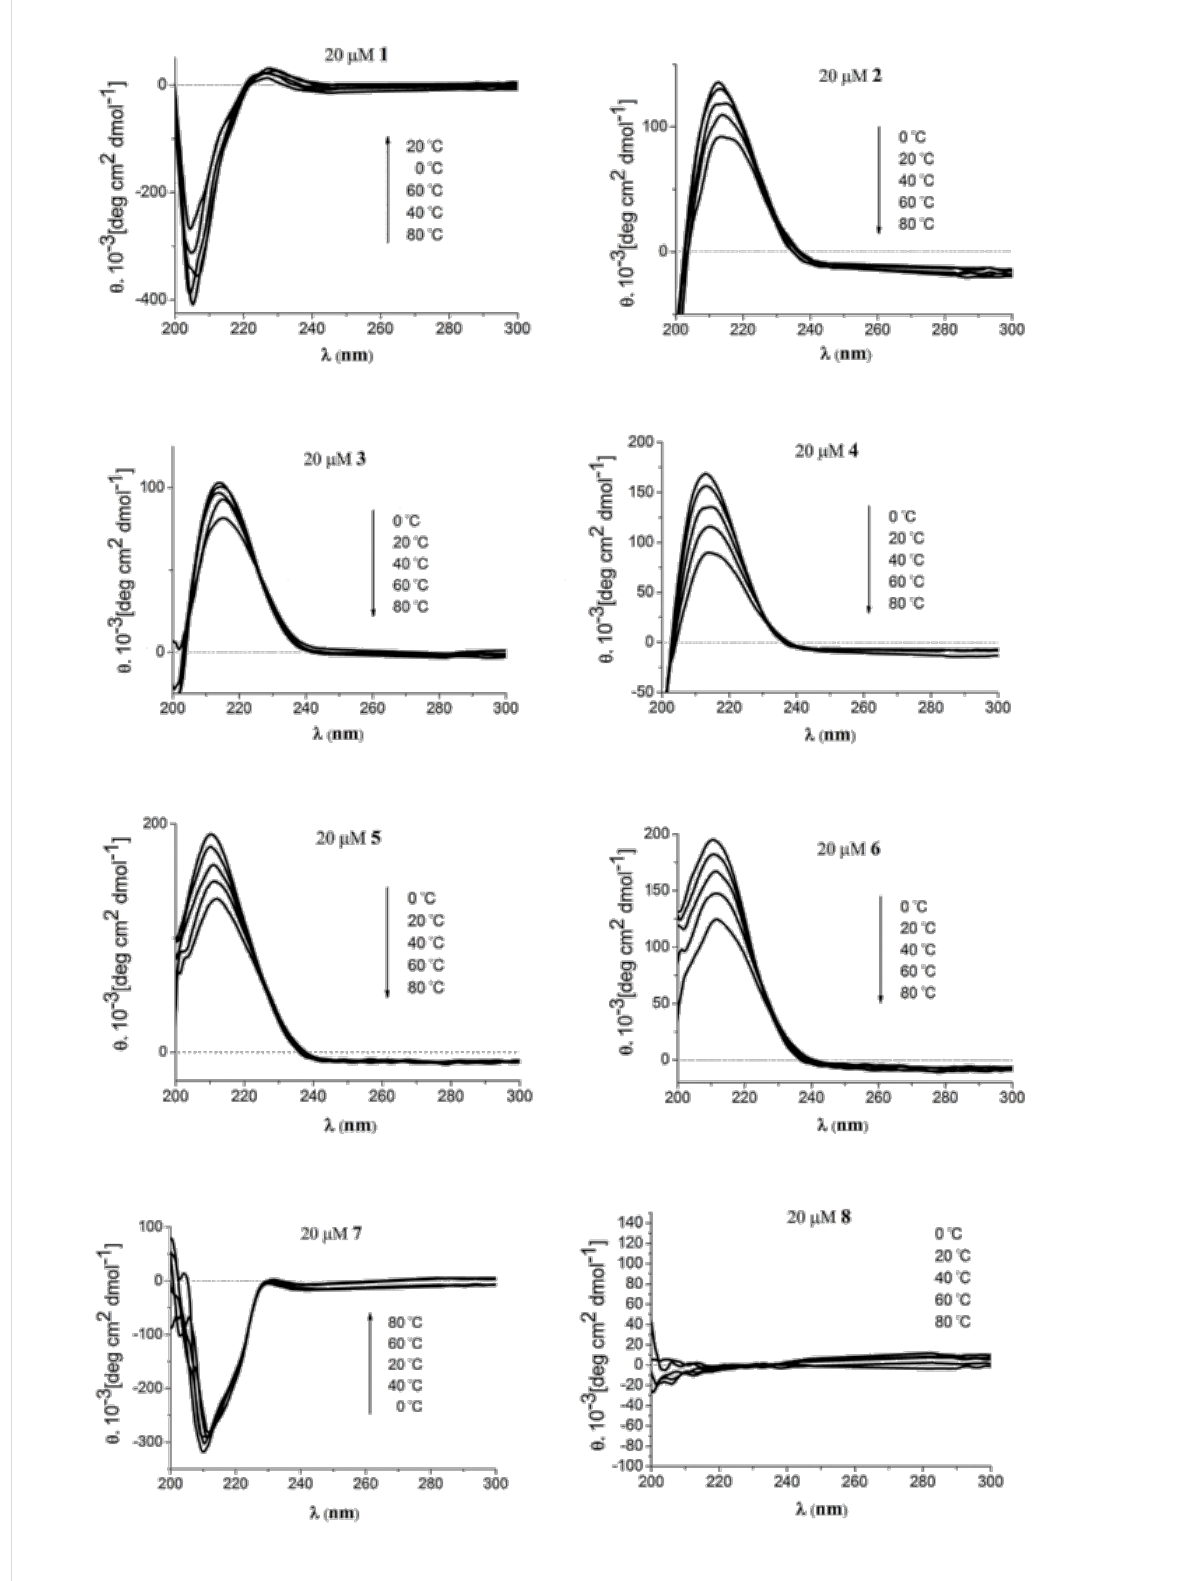
Figure 5: CD spectra of β -glycopeptides 1 – 8 ( c = 20 μ M) in triethylammonium acetate buffer (5 mM, pH 7) at various